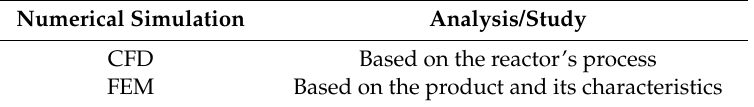
Table 1. Numerical simulation methods and their focus: CFD and